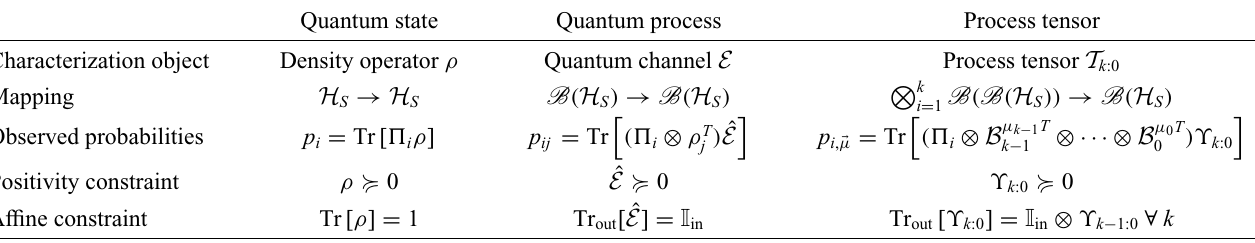
TABLE I. Detail on different levels of the quantum tomography hierarchy, pertinent to experimental reconstruction. QST reconstructs a density operator, ρ , a positive matrix with unit trace representing the quantum state. QPT reconstructs a quantum channel, E , through its action on different states. This map must be both CP and TP, conditions which, in Choi form, manifest themselves as positivity and affine constraints on the matrix. Finally, PTT reconstructs a process tensor T k :0 through its action on different control operations. This object must have a positive-matrix Choi form and must respect causality. The information of each column is strictly contained in the column to the right.